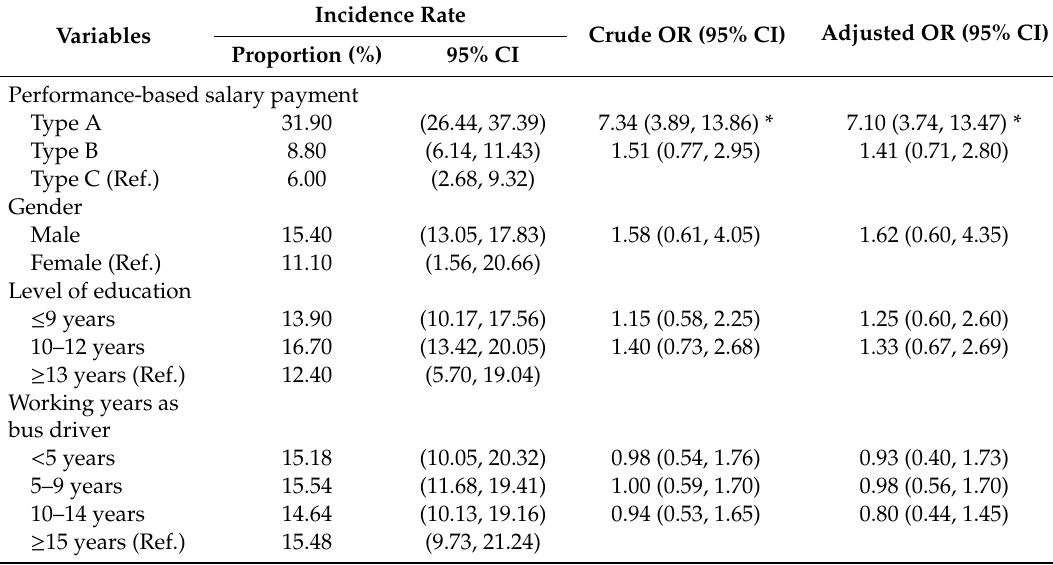
Table 3. Associations between self-reported bus crashes in the past month, type of bus company, and driver